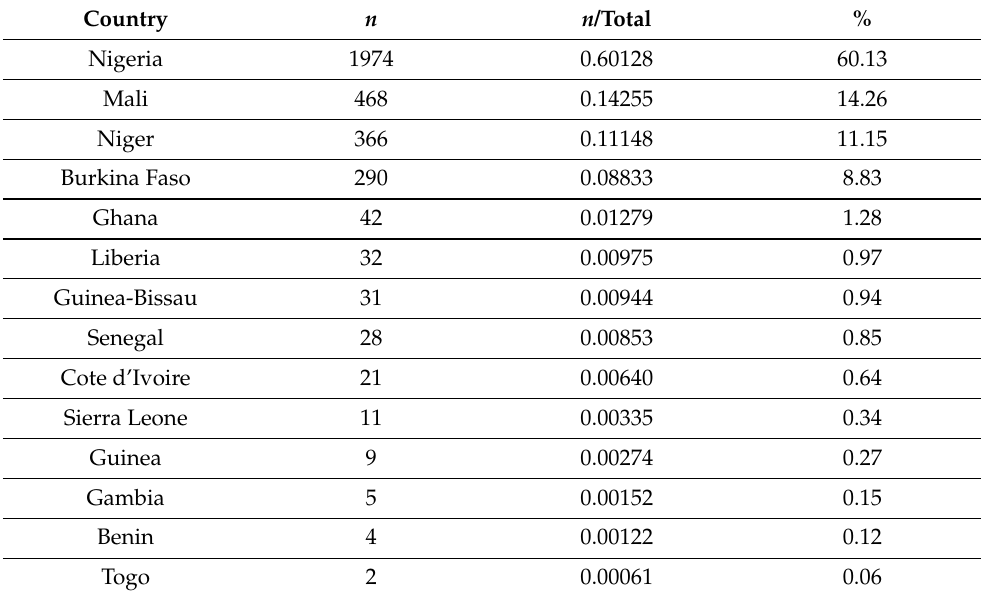
Table 4. Media coverage received by West African countries regarding the refugee